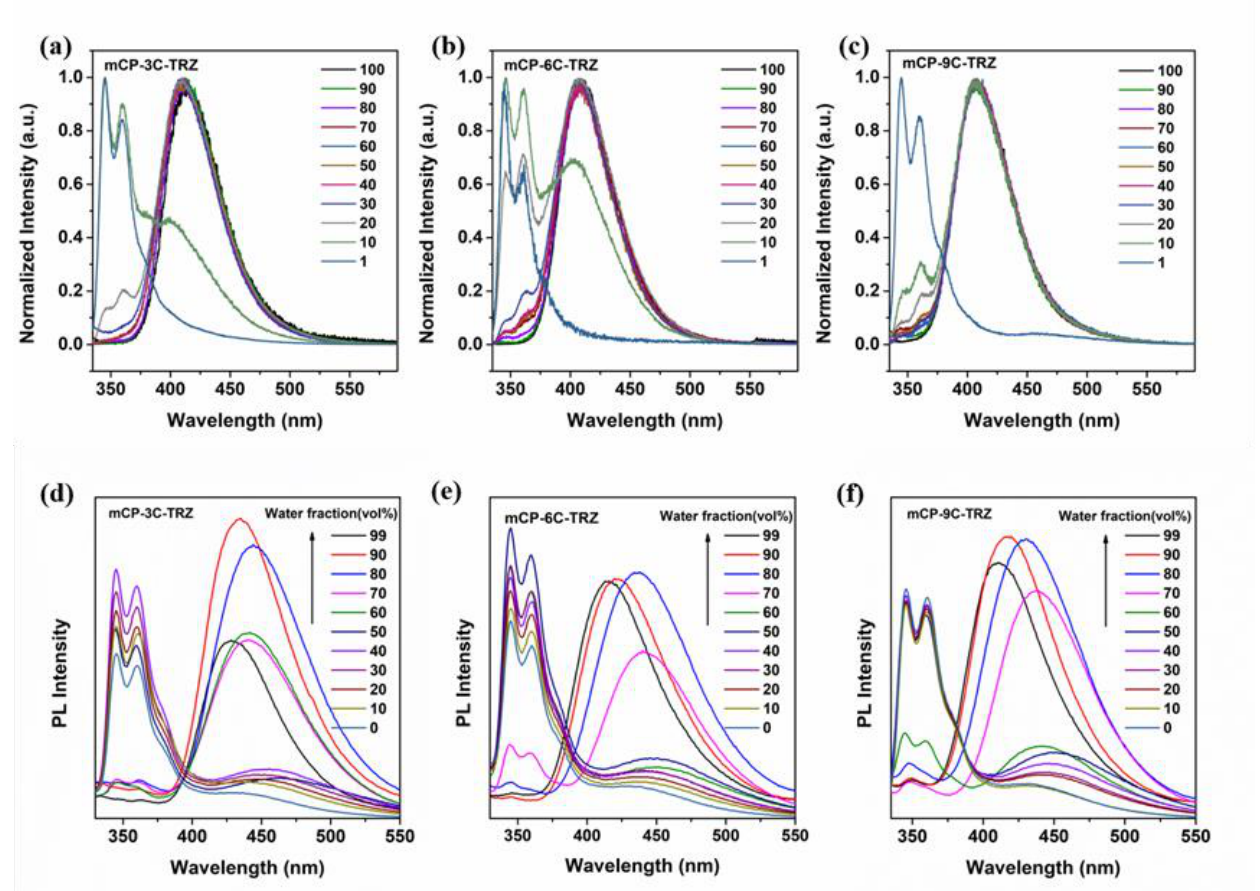
Figure 5. The normalized PL spectra of doped films when mCP-3C-TRZ ( a ), mCP-6C-TRZ ( b ) and mCP-9C-TRZ ( c ) were diluted into PMMA matrix. Additionally, the fluorescence spectra of mCP- 3C-TRZ ( d ), mCP-6C-TRZ ( e ) and mCP-9C-TRZ ( f ) in mixed THF/water solutions of 1 × 10 ₋5 M con- centration with various water fractions under ambient temperature. Table 1. Basic photophysical and electrochemical parameters of mCP-3C-TRZ, mCP-6C-TRZ, and mCP-9C-TRZ.